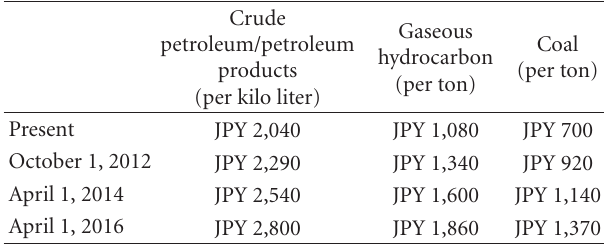
Table 1: FY2012 proposed tax rates.